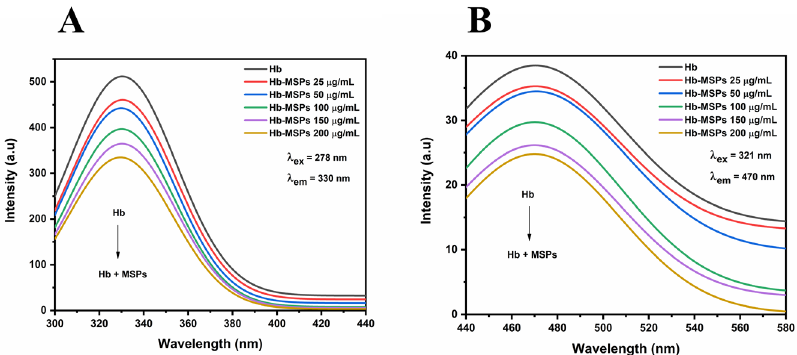
Figure 5. ( A ) Steady-state fluorescence spectra of Hb and Hb-MSPs at 278 nm excitation wavelength. ( B ) Heme degradation study of Hb-MSPs at 321 nm excitation wavelength.